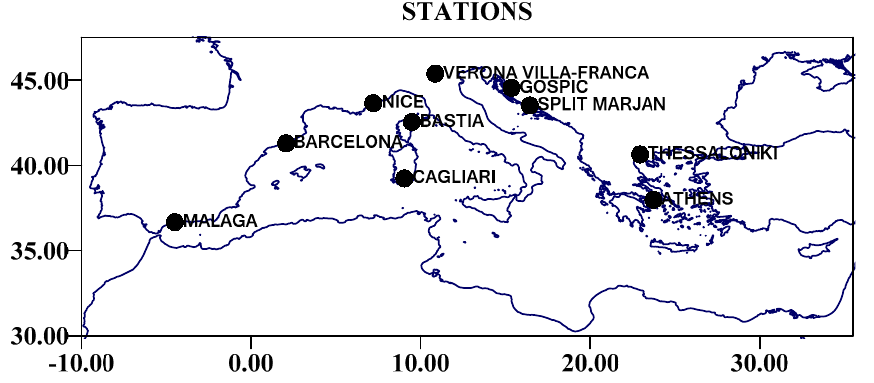
Figure 1. The geographical distribution of the 10 studded